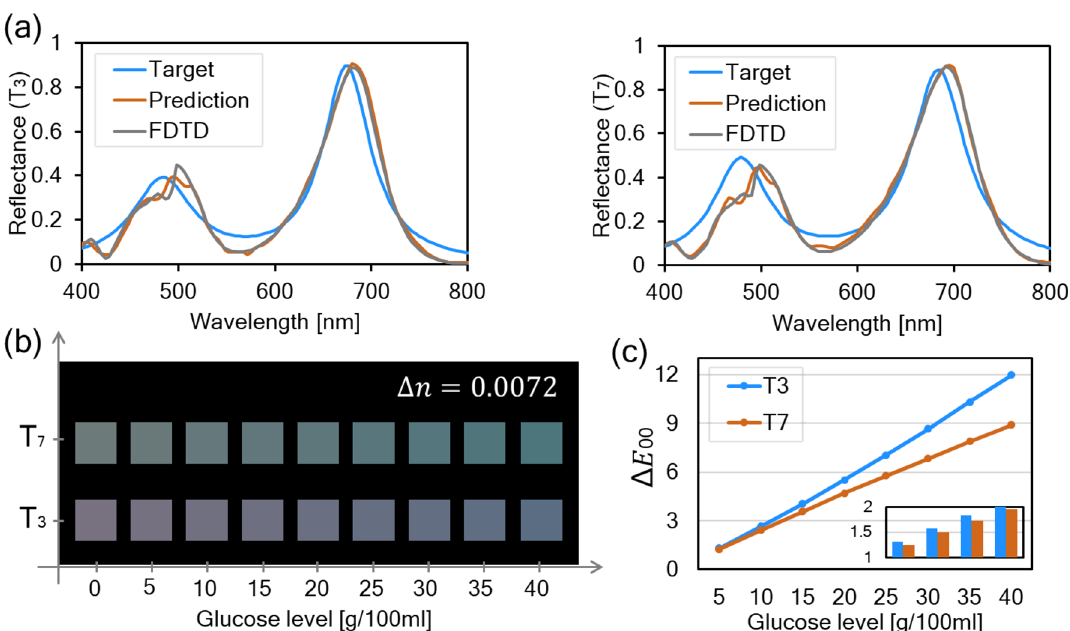
Figure 5. ( a ) Comparison between target spectral lineshape, predicted spectrum through DNN, and FDTD simulation results from the predicted geometric parameters according to the two target spectra showing the lowest loss from Table 1 (T 3 and T 7 ). ( b ) For T 3 and T 7 , variations in reflected structural color appearing when glucose level is changed by 5 g/100 ml from 0 to 40. ( c ) Graph showing the calculated Δ E 00 corresponding to the color difference shown in ( b ). Inset represents calculated Δ E 00 when the glucose level is changed from 5 to 8 by 1 g/100 ml in order to determine resolution limit of the proposed colorimetric